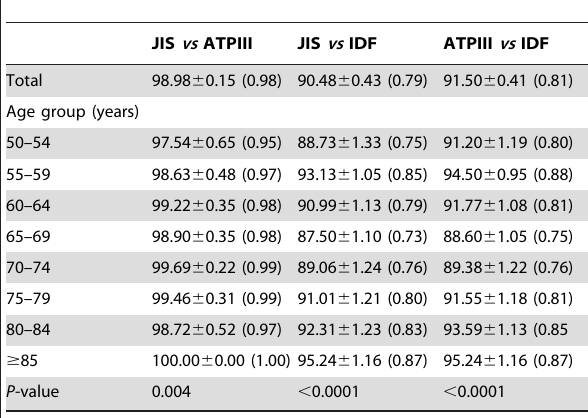
Table 3. Agreements* between the JIS, ATPIII-modified, and IDF criteria in diagnosing metabolic syndrome among postmenopausal women in rural Canton (n=